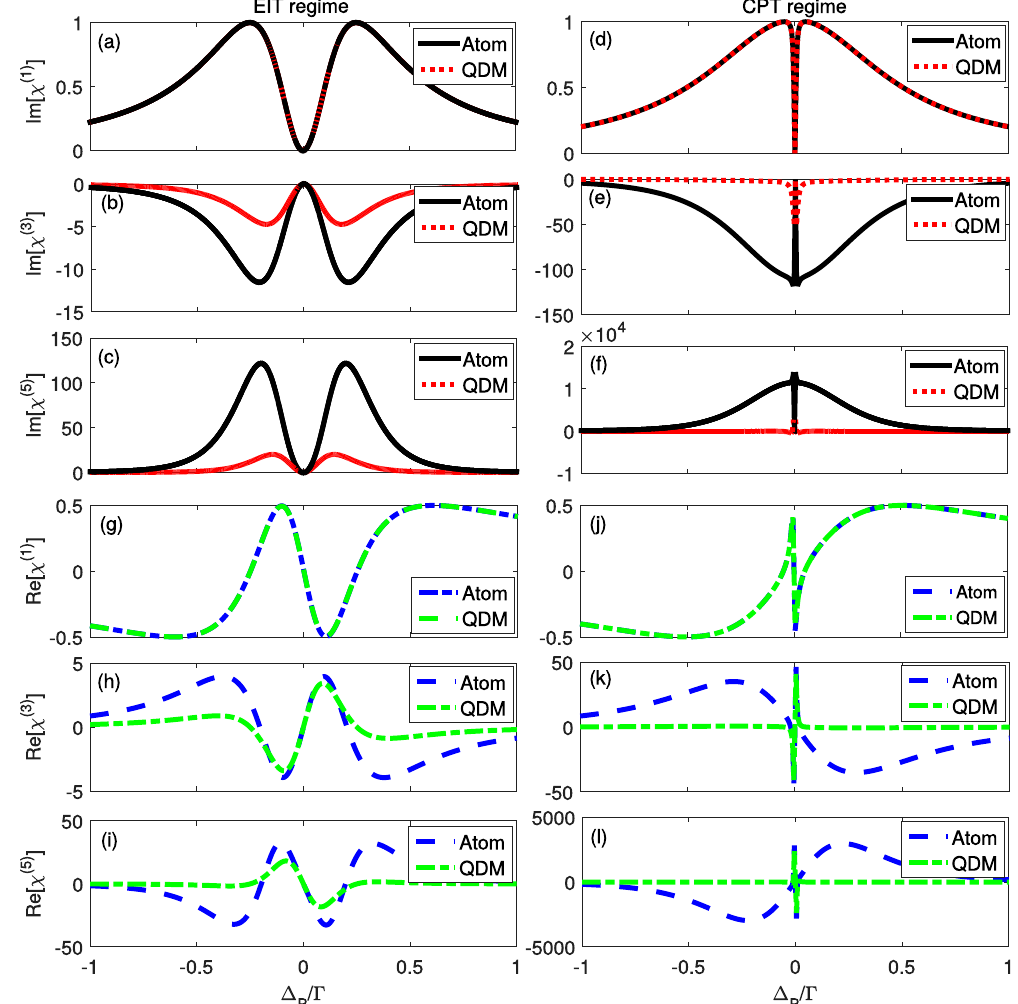
Figure 3. Linear and nonlinear optical susceptibilities. In panels ( a–f ) [and from ( g–l )] we plot the imaginary [real] part of χ n ( ) ( n = 1, 3, 5) for the atomic/quantum dot molecule systems in two different regimes of parameters, i.e., EIT (left panels) and CPT (right panels), considering the same set of parameters as in Fig.